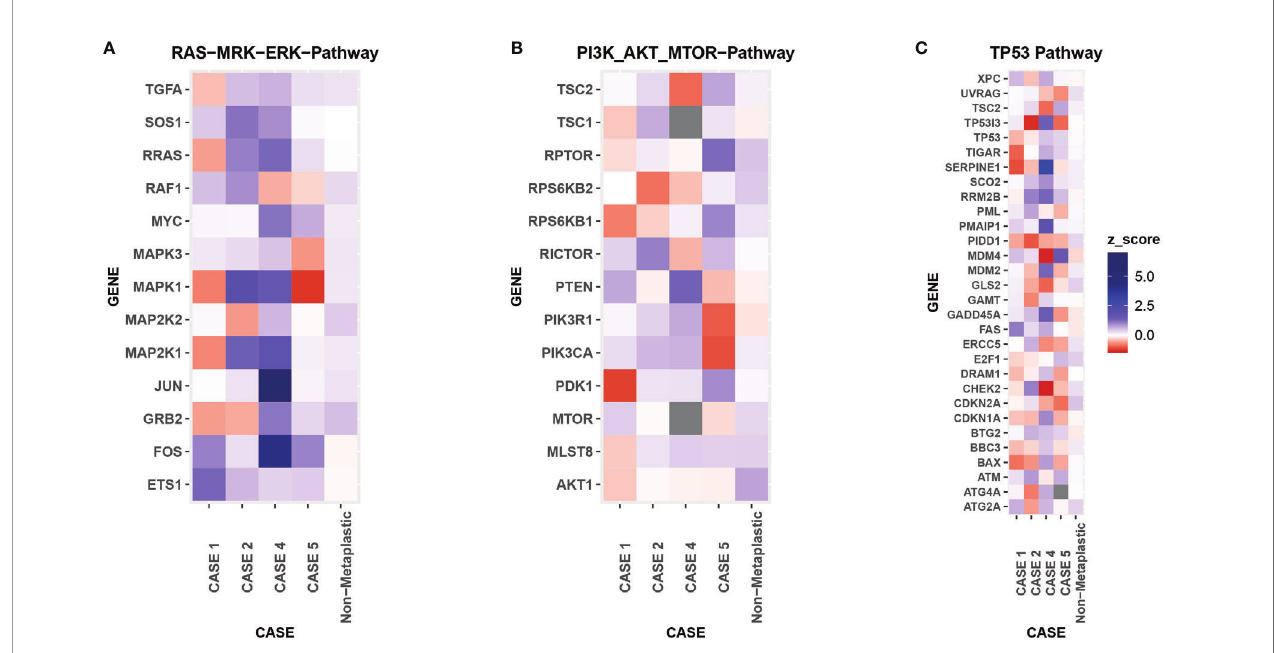
FIGURE 8 | RNA Heat Map. RNA expression heatmaps with modi fi ed z-scores of expression vs non-metaplastics represented for each patient for 3 molecular pathways of interest in metaplastic breast cancer, (A) RAS-MRK-ERK pathway, (B) PI3K-AKT-mTOR pathway, (C) TP53